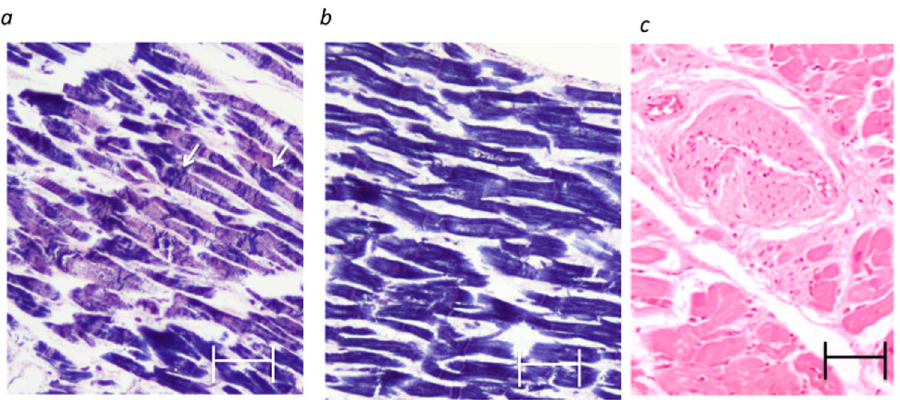
Figure 2. Histological analyses of samples. Representative PTAH staining ( a , b ) and H&E staining of the contraction bands in the ischemic endocardial lesion. Arrowheads, contraction bands ( a ). Damaged arterioles with intimal thickening ( c ). Scale bars, 20 μ m in ( a – c